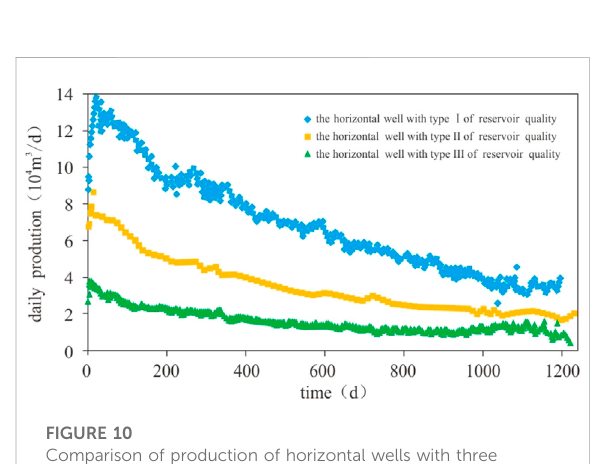
FIGURE 11 Comparison of horizontal well pressure for three types of reservoir